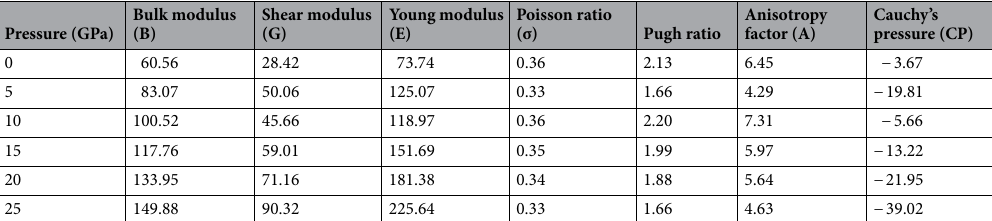
Table 2. Mechanical parameters of the CdZnSe alloy at various pressures ranging from 0 to 25